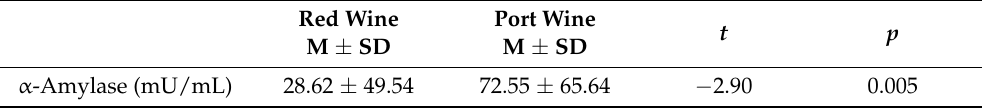
Table 6. Descriptive measurements and univariate effects of enzymatic activity ( α -amylase) in alcoholic beverages (red wine and port wine) and Student’s t-test for independent